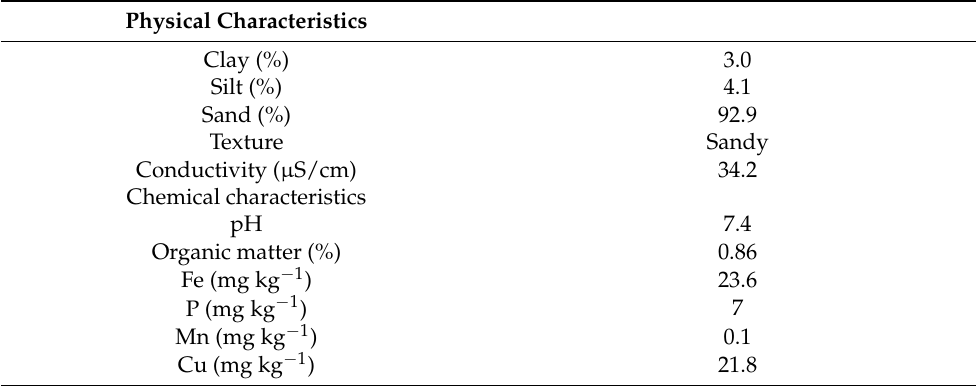
Table 2. Soil physical and chemical characteristics.